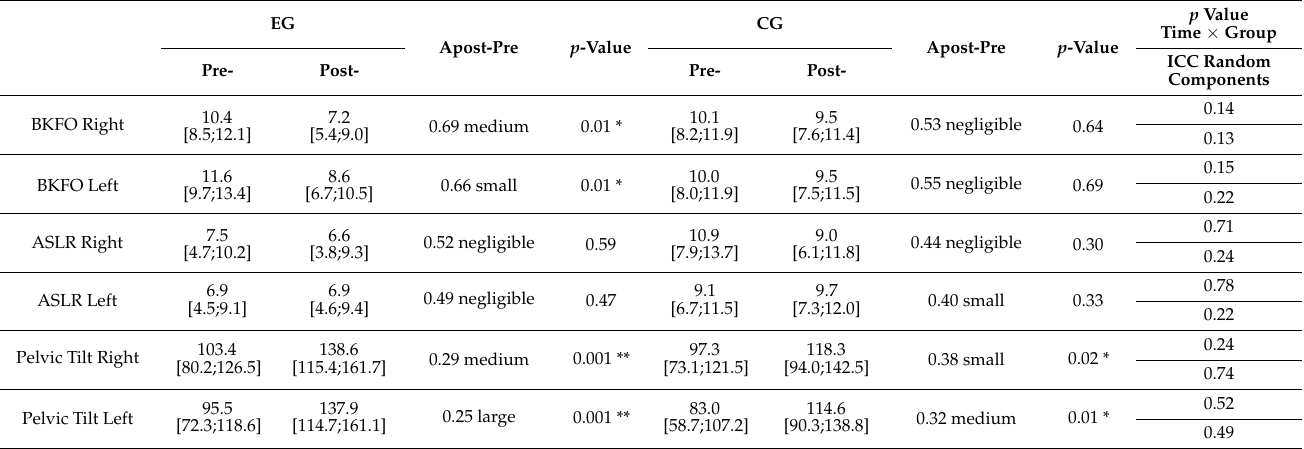
Table 3. CS test results.